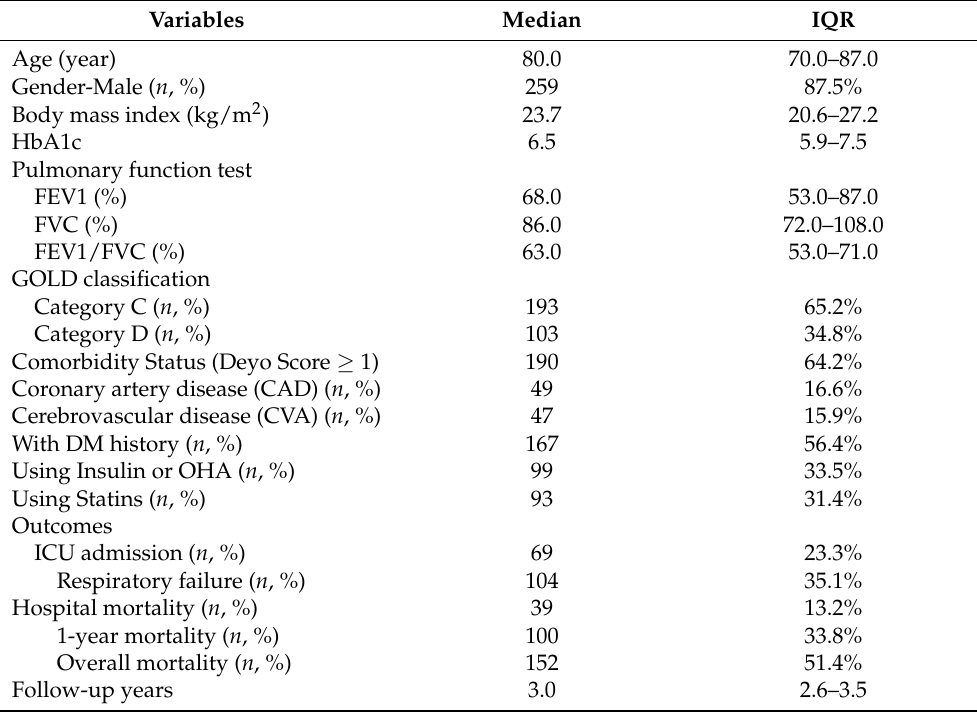
Table 1. Demographic characteristics, baseline glucose status, comorbidities, and outcomes of